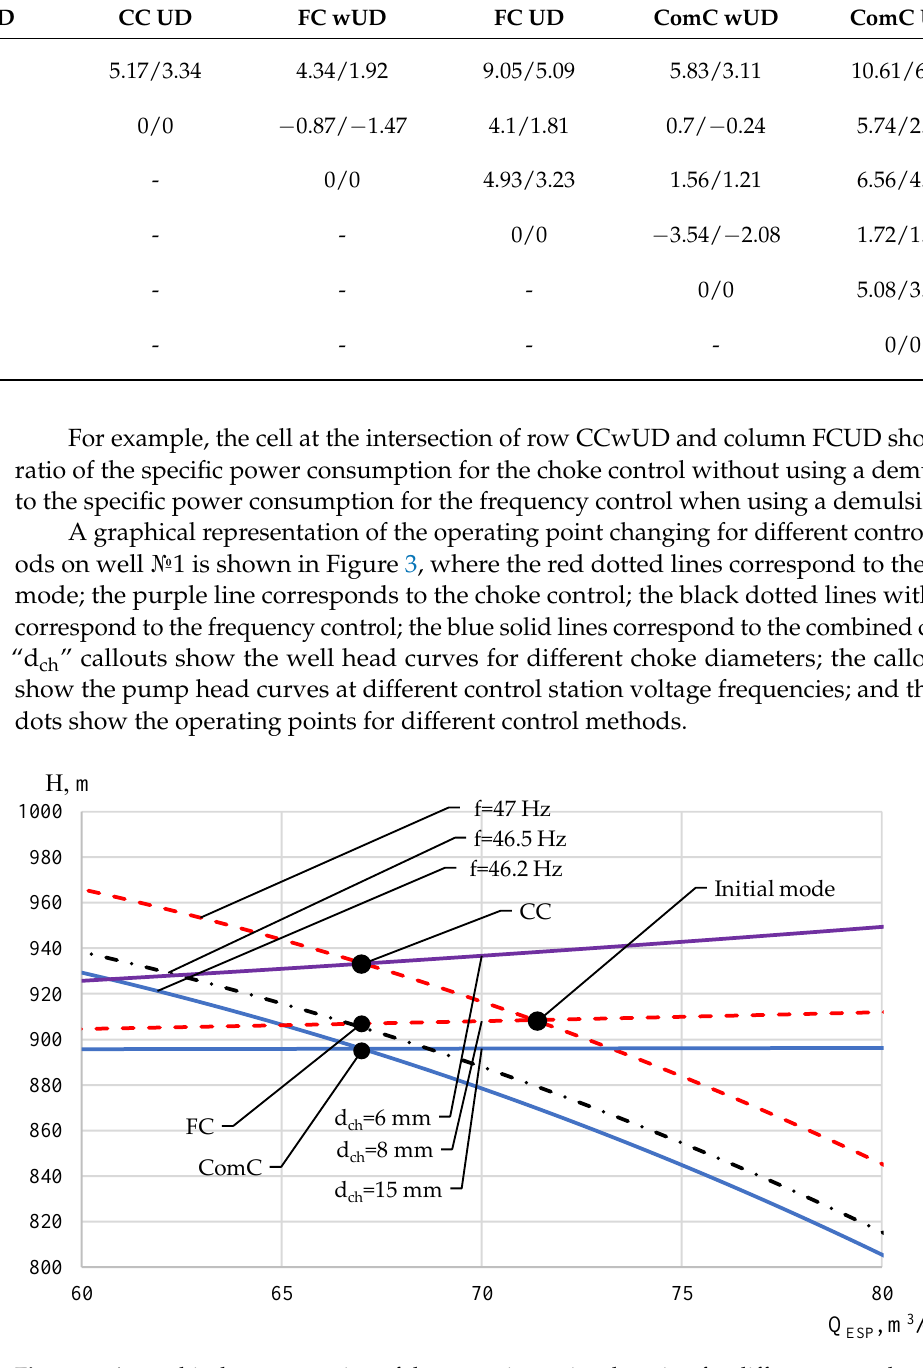
Figure 3. A graphical representation of the operating point changing for different control methods.